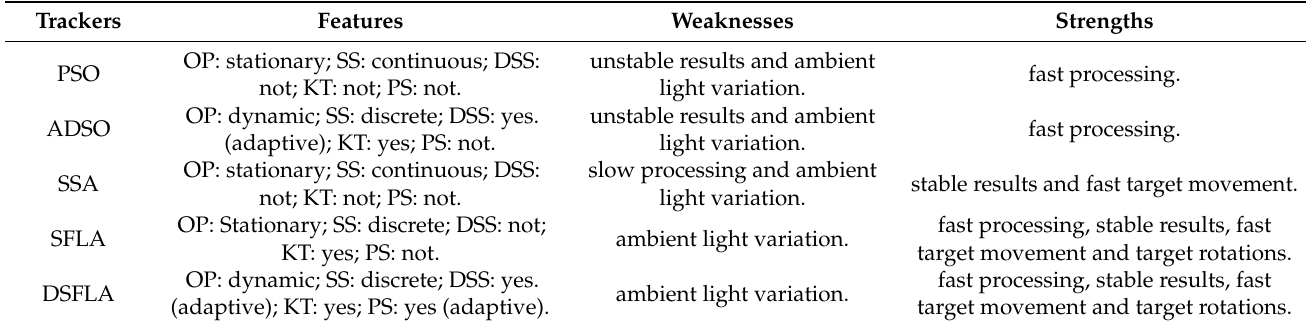
Table 1. The features of the trackers.